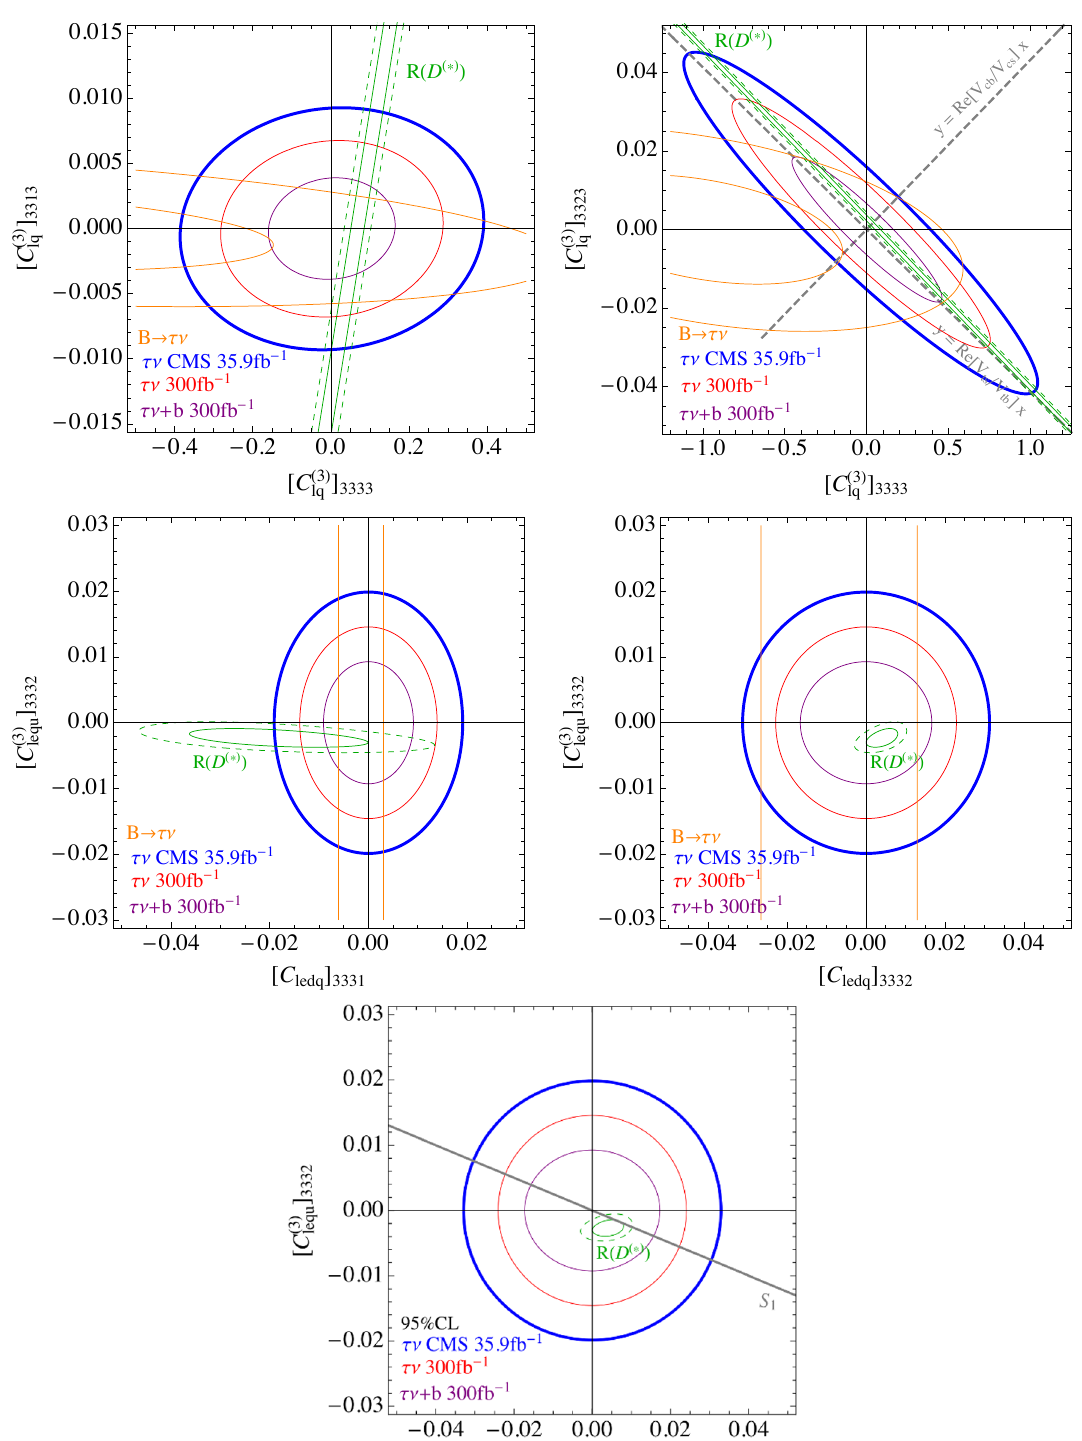
Figure 9 . 95% CL limits and prospects in several pairs of SMEFT coefficients, while other operators are set to zero. The solid (dashed) green lines are 1(2) σ contours from the R ( D ( ∗ ) ) fit [29], while orange lines are 95% CL limits from B → τν